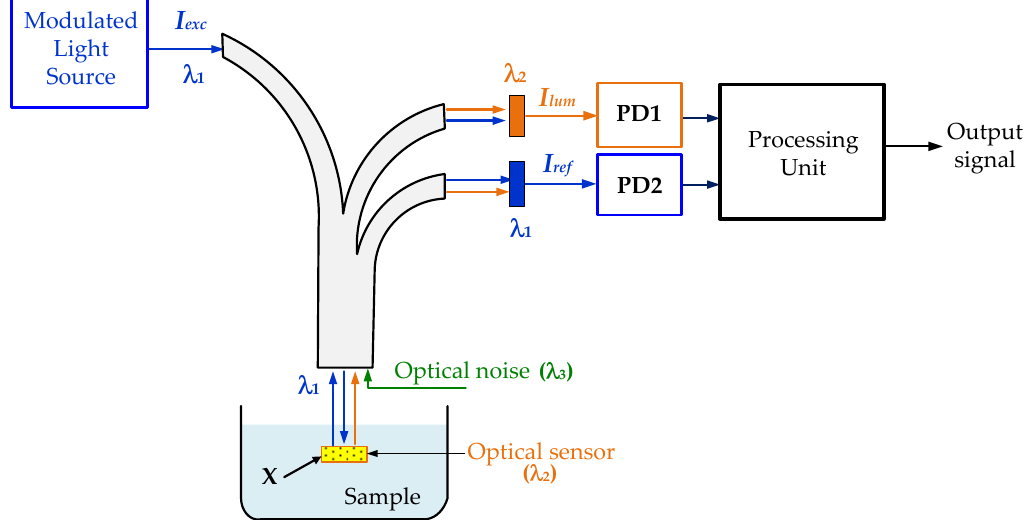
Figure 12. Instrumentation setup for a fiber optic sensor based on the ratiometric measurement of intensity. PD = photodetector. Table 6. Advantages and disadvantages of common luminescence spectroscopy techniques. Spectroscopy